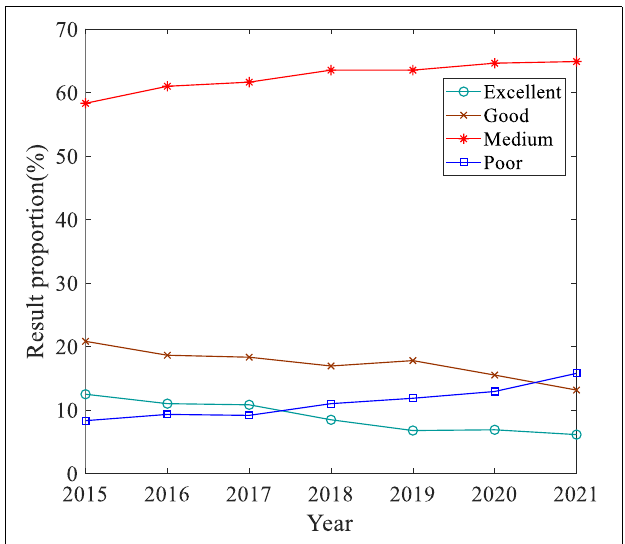
FIGURE 7 | Evaluation of experiment and practice courses.